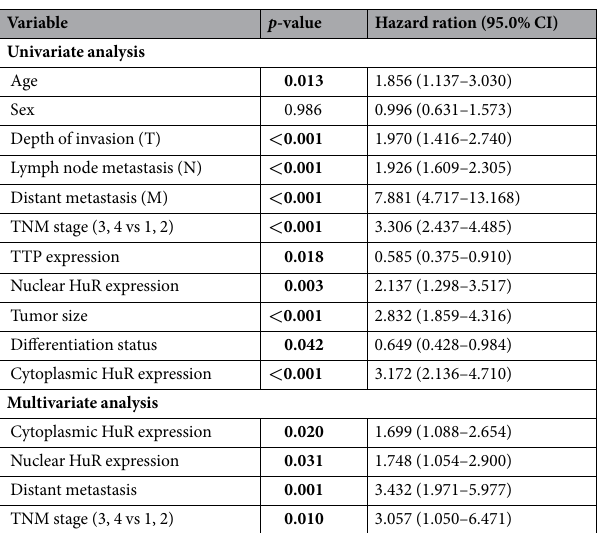
Table 4. Univariate and multivariate analyses for the overall survival of GC patients. P value < 0.05 was indicated in